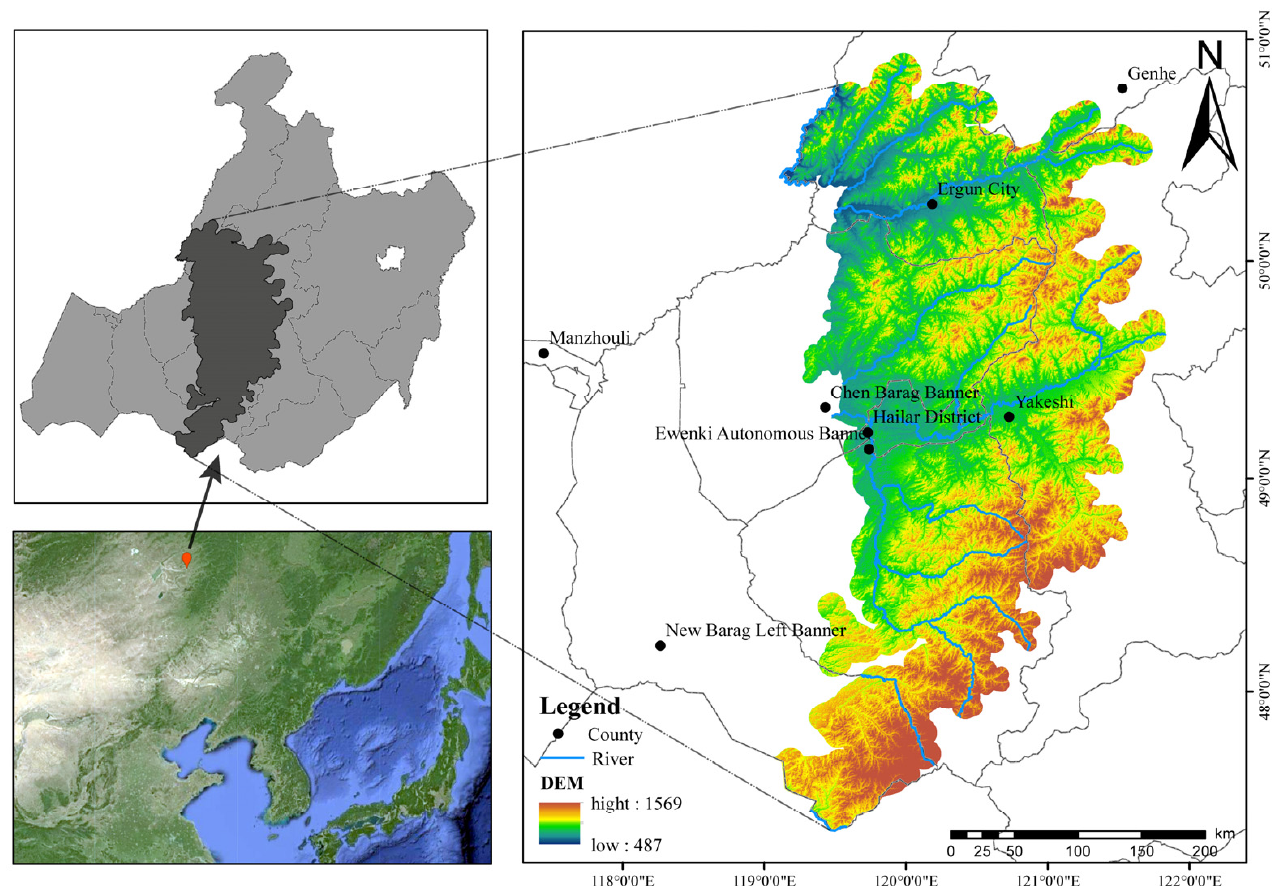
Figure 1. Study area of the Hulunbuir forest–steppe ecotone in China.